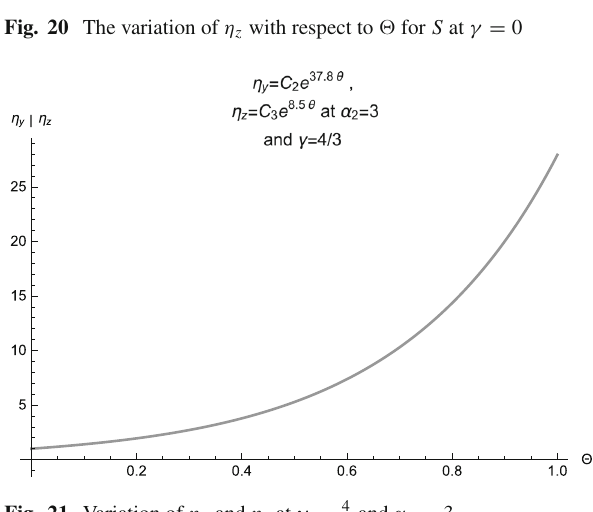
Fig. 21 Variation of η y and η z at γ = 4